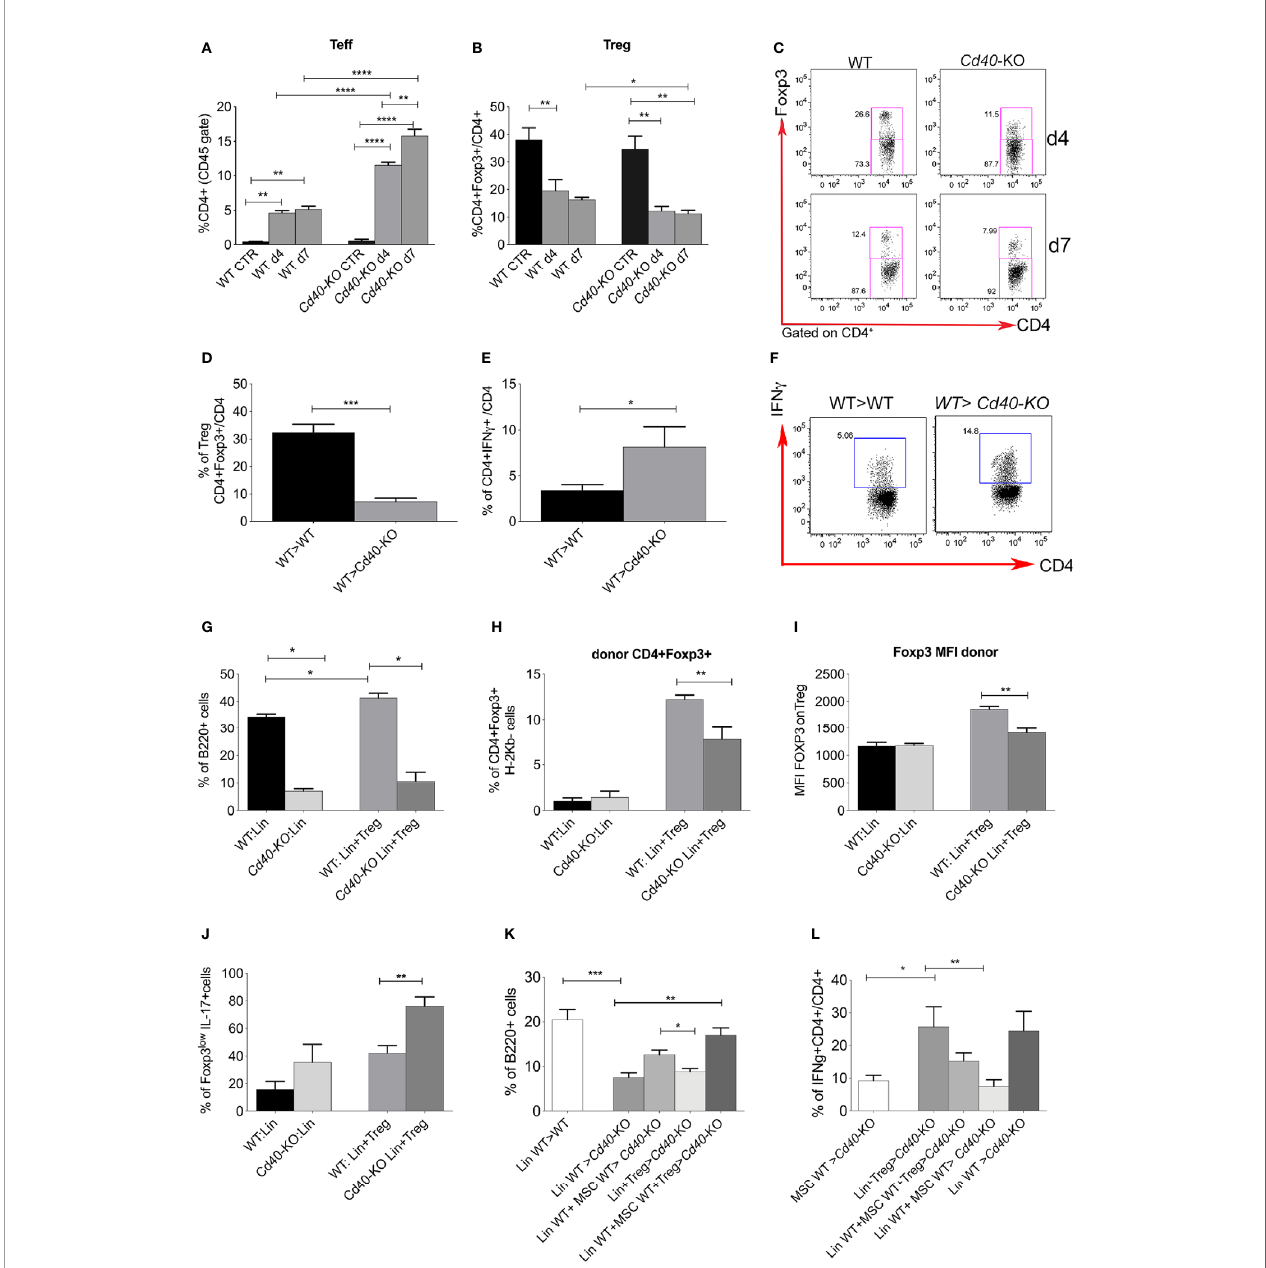
FIGURE 4 | Characterization of T-cell status in the Cd40 -KO recipient BM chimeras. (A) Frequency of Teffs (CD25-Foxp3 − ) and (B) Tregs (CD25+Foxp3+) in WT and Cd40 -KO irradiated mice (CD4 gate) compared to that in naive control mice (n = 4 per group). **p < 0.005, ***p < 0.001, ****p < 0.0001, Student t test. (C) Representative dot plot showing Tregs in wt and Cd40 -KO mice upon irradiation (D) Frequency of Tregs in the BM of WT>WT and WT> Cd40- KO BM chimeras (n = 4 per group, ***p < 0.001, Student t test). (E) Cumulative data and (F) representative dot gating strategy showing the production of IFN g by CD4+Foxp3 − Teffs in the BM of WT>WT and WT> Cd40- KO BM chimeras (n = 4 per group, *p < 0.05, compared according to Student ’ s t test, one representative experiment out of two performed). (G) Frequency of B220+ cells in the WT>WT and WT> Cd40- KO BM chimeras after lethally irradiating CxB6F1 WT or Cd40- KO mice with lin- cells and spleen-derived Tregs from donor BALB/c mice (n = 5 per group). *p < 0.05, compared according to Student ’ s t test. (H) Frequency of donor (H-2Kd + Kb - ) CD4+Foxp3+ Tregs in the WT>WT and WT> Cd40- KO BM chimeras reconstituted with lin- and Tregs (n = 5 per group). *p < 0.05, compared according to Student ’ s t test. (I) Cumulative data showing the MFI of Foxp3 on Treg cells. (J) IL-17 production by Foxp3 low Tregs in Cd40- KO recipients (n = 5 per group). **p < 0.005, compared according to Student ’ s t test. (K) Frequency of B-cells in the BM of Cd40-KO and WT mice receiving Lin- cells co-infused with Treg and MSC from WT donors (n= 4/group, p < 0.05; **p < 0.005, One-way ANOVA, Dunnett ’ s multiple comparison test). (L) Frequency of IFN g − producing CD4+ cells in BM transplanted Cd40-KO and WT mice receiving Lin- cells co-infused with Treg and MSC from WT donors (n= 4/group, p < 0.05; **p < 0.005, One-way ANOVA, Dunnett ’ s multiple comparison